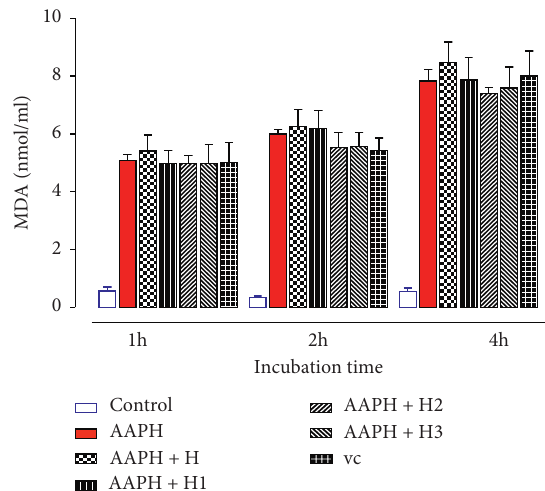
Figure 6: Effects of piperine derivatives on AAPH-induced MDA levels in rat